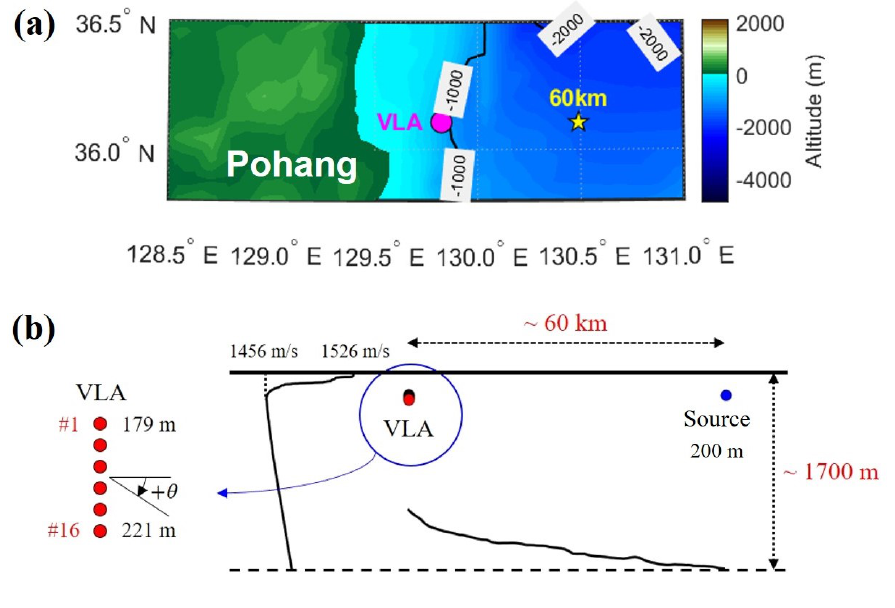
Figure 3. ( a ) Bathymetry of the experimental area in the East Sea. Depth contours are in meters. The biomimetic long-range acoustic communication 2018 (BLAC18) experiment was conducted in October 2018. The five-point star indicates the source location and the magenta circle indicates the VLA location. ( b ) Schematic of the BLAC18 experimental setup. The red and blue solid circles indicate the receivers and sources, respectively. A 16-element, 42-m-long VLA moored to the sea floor in water with an approximate depth of 950 m recorded the communication signals. A positive angle denotes an upward ray path. The sound-speed profile was determined by measuring the